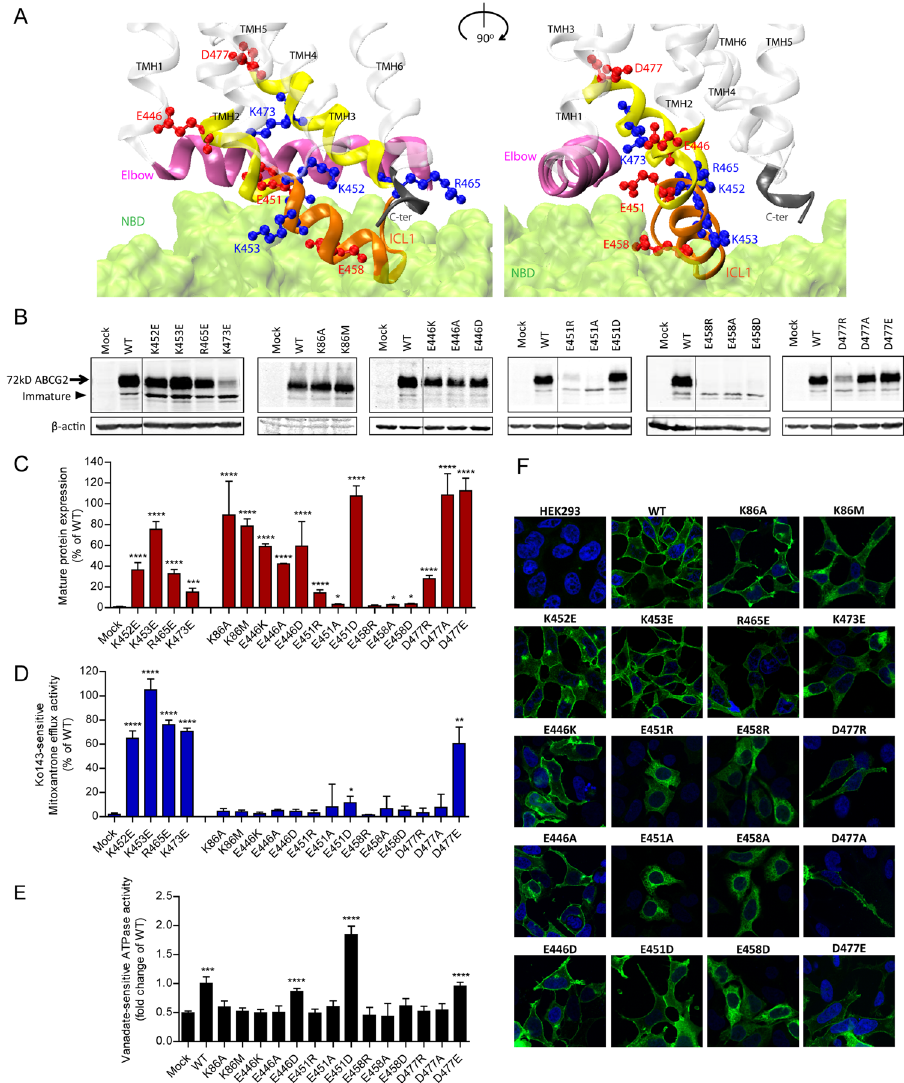
Figure 2. Mutational analysis of the transmission interface. All charged resideus in the predicted TMH2, ICL1 and TMH3 were subjected to mutational changes as indicated. ( A ) Configuration at the transmission interface of a human ABCG2 monomeric half transporter in two views rotated by 90°, emphasizing the contacts of the transmembrane domain (TMD) with the NBD surface (green); ICL1 (orange); TMHs (transparent white); distal helical parts of TMH2 and TMH3 (yellow); elbow helix (pink); C-terminus (black). Charged residues are indicated as colored balls-and-sticks, positive charges (blue), negative charges (red); not drawn to atomic scale. ( B ) Immunodetection of ABCG2 variants using the monoclonal mouse anti-ABCG2 (BXP-21) antibody. Mature wild type (WT) ABCG2 migrates to approximately 72 kD, the bands below are immature unglycosylated monomers. β -actin was used as a loading control. ( C ) Quantified immunoblot using the Odyssey system from several independent experiments (n = 2–12). Mature ABCG2 and β -actin were gated, and ABCG2 signals were individually normalized to β -actin and shown as a percentage of WT. The blots from different gels were divided by the white spaces. ( D ) Mitoxantrone efflux in transfected HEK293 cells after incubation at 37 °C for 20 min in the presence and absence of Ko143. Ko143– sensitive mitoxantrone efflux is given as percentage relative to WT. Data are from several independent experiments (n = 2–7). ( E ) Vanadate-sensitive ATPase activity of ABCG2 variants in transfected HEK293 cells. Vanadate-sensitive ATPase activity is represented as a fold change relative to WT. Data are from several independent experiments (n = 8) using three batches of membrane preparations. The ATPase-dead mutants, K86A and K86M served as additional controls. All data are shown as mean and SEM. **** P < 0.0001; *** P < 0.001; ** P < 0.01; * P < 0.1 vs. empty plasmid transfected HEK293 (mock). ( F ) Membrane localizations of GFP-tagged ABCG2 variants were visualized by confocal microscopy to detect GFP-tagged ABCG2 variants (green). Nuclear DNA was stained with DAPI (blue). Microscopy data are from duplicate